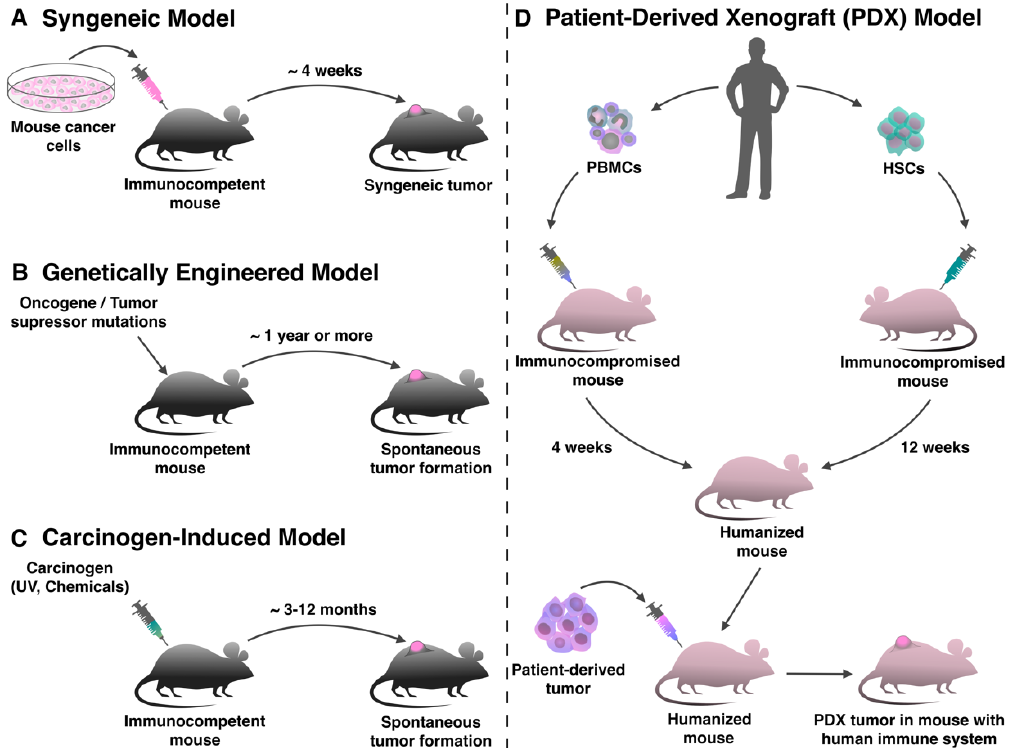
Figure 1. Production of mouse tumor models for evaluation of immunotherapy. ( A ) Syngeneic tumor models are produced by transplanting mouse tumor cell lines into immunocompetent animals in a short period of time. ( B ) In genetically engineered tumor models, the tumor forms de novo as a result of specific genome modification. ( C ) In mice treated with carcinogens, the tumor also forms spontaneously de novo. ( D ) For the production of patient-derived xenograft (PDX) models with human immune system immunocompromised mice can be humanized with peripheral blood mononuclear cells (PBMCs) or hematopoietic stem cells (HSCs), and after that transplanted with a human tumor.